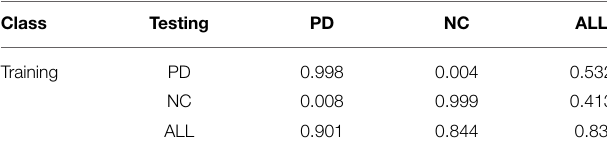
TABLE 8 | Transfer of learning in games with a unique PSNE (probability of joint PSNE